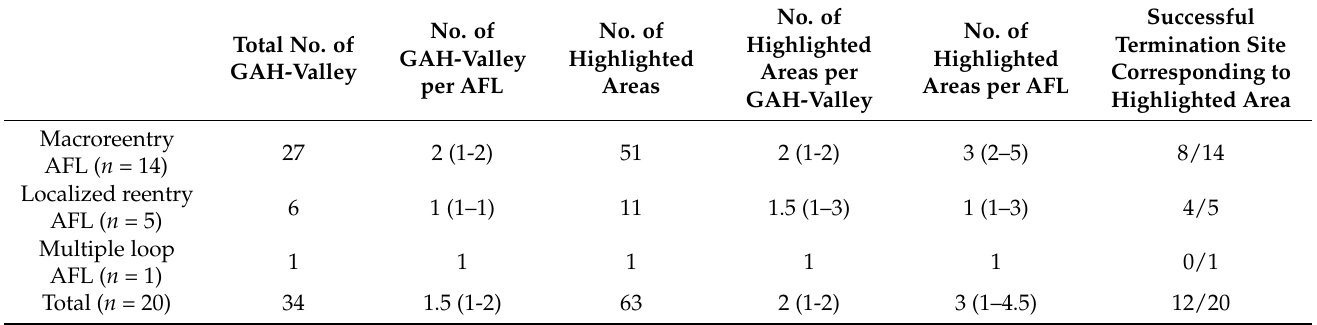
Table 2. Highlighted areas and lowest GAH-Valley in LUMIPOINT algorithm.